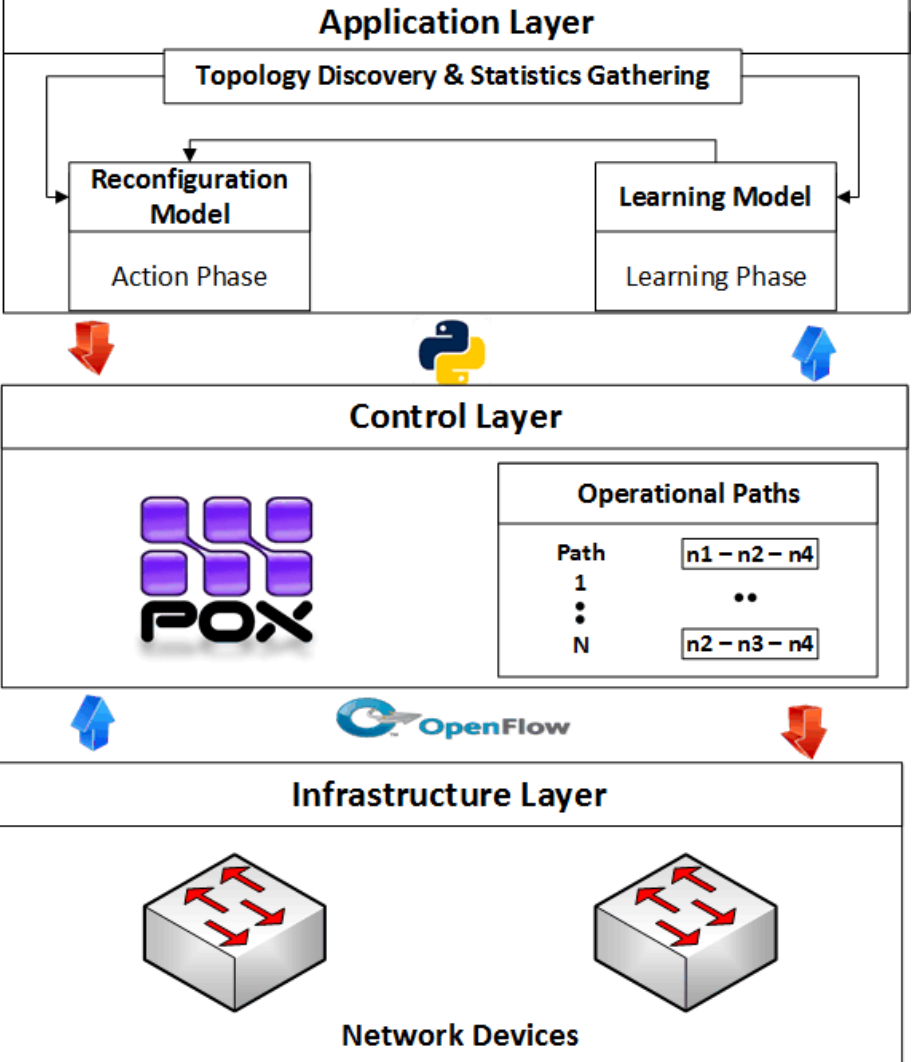
Figure 7. An SDN controller has the ability to adaptively reroute the operational paths for a video delivery system by integrating QoD measurements from an ML model. Integration of CNAA predictions with an SDN controller in a feedback loop is able to preserve the video quality by avoiding congested